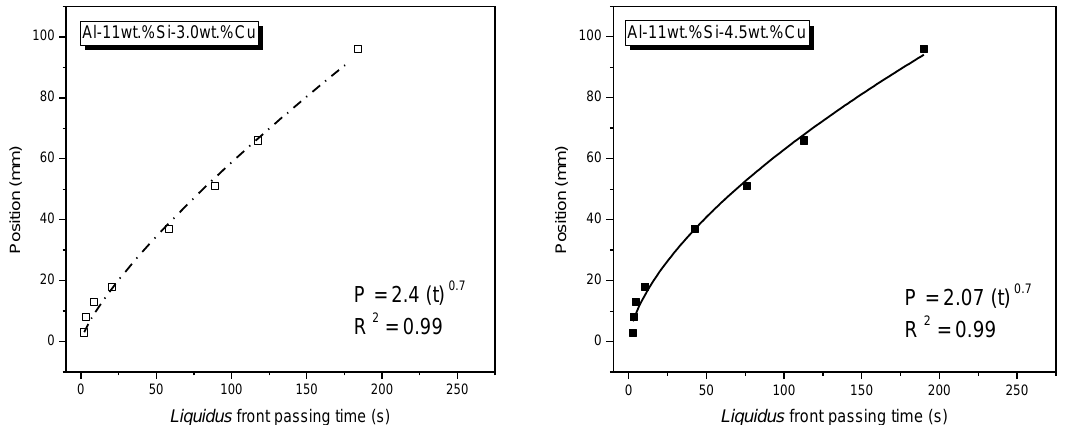
Figure 4. Experimental time-dependent ( t ) displacements of the liquidus isotherm along the casting length ( P ) of the Al-11Si- x Cu alloys. R 2 is the coefficient of determination.